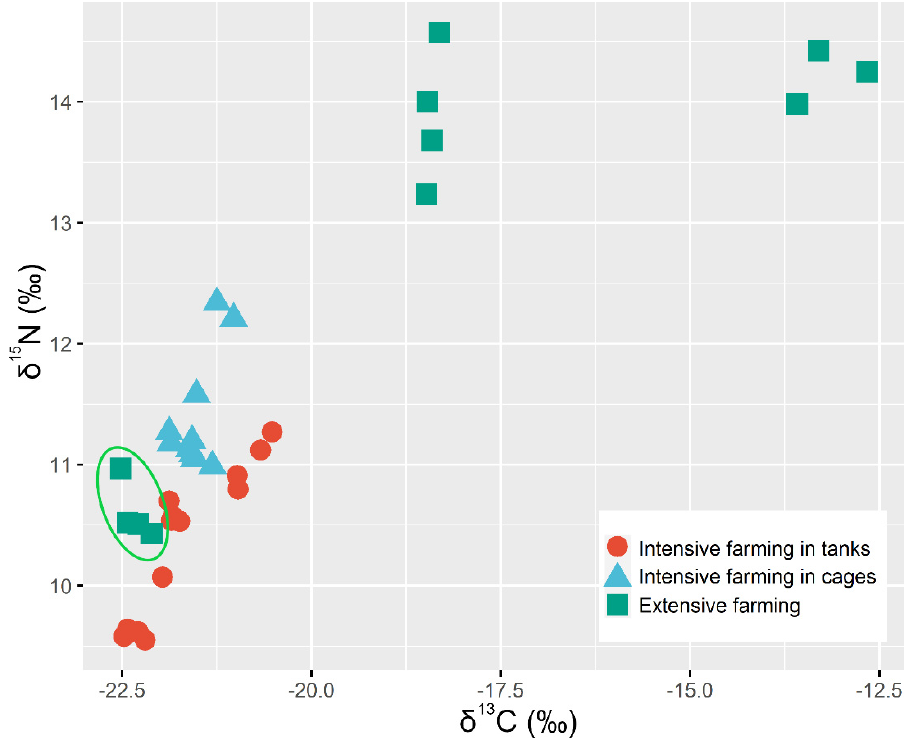
Figure 1. δ 13 C and δ 15 N values in sea bass muscle. Each data point represents the measure of a pooled sample of 5 fish fillets. Table 4. δ 13 C and δ 15 N trophic shifts for intensive (inland and sea cages) or semi-intensive (E3) reared sea bass.